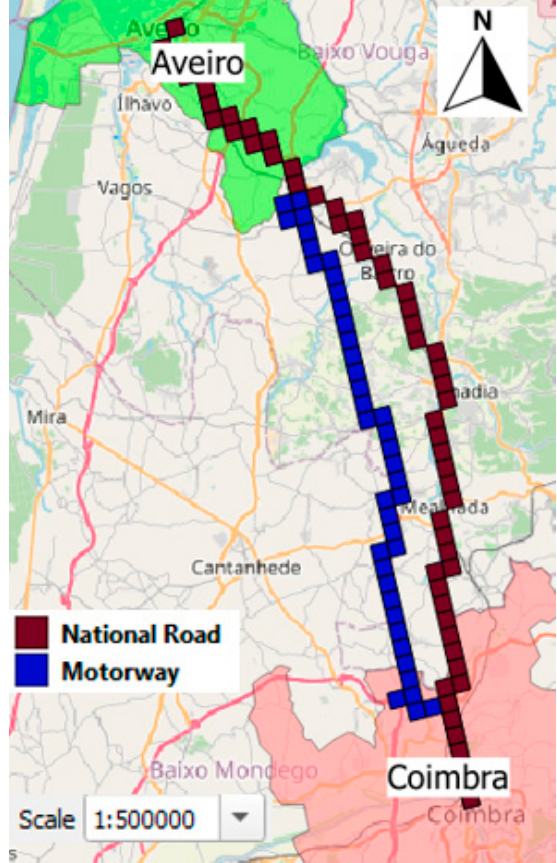
Figure 2. Case study visual representation.